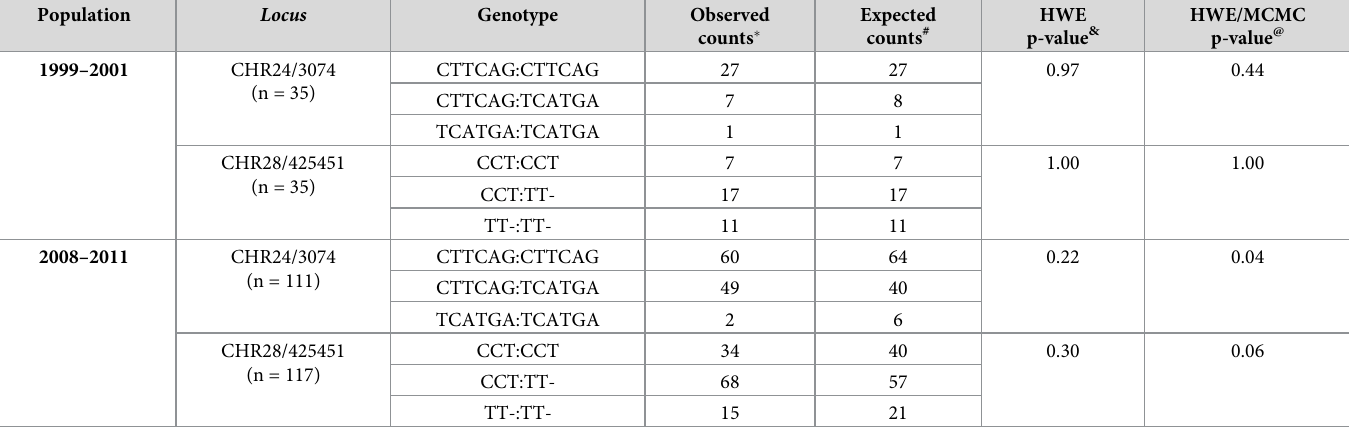
Table 1. Hardy-Weinberg equilibrium testing of genotypes in two temporally distinct L . braziliensis populations endemic in Corte de Pedra, Northeast Brasil: 1999–2001 and 2008–2011.